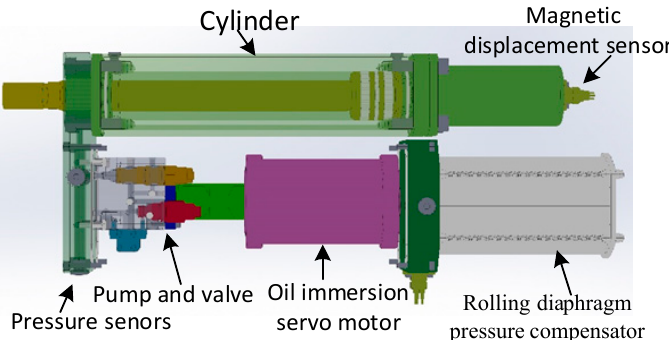
Figure 1. Structural design of underwater EHA: An electric servo-motor, micro piston pump, signal rod cylinder, and rolling diaphragm pressure compensator. The addition of a rolling diaphragm pressure compensator is used to overcome seawater pressure.